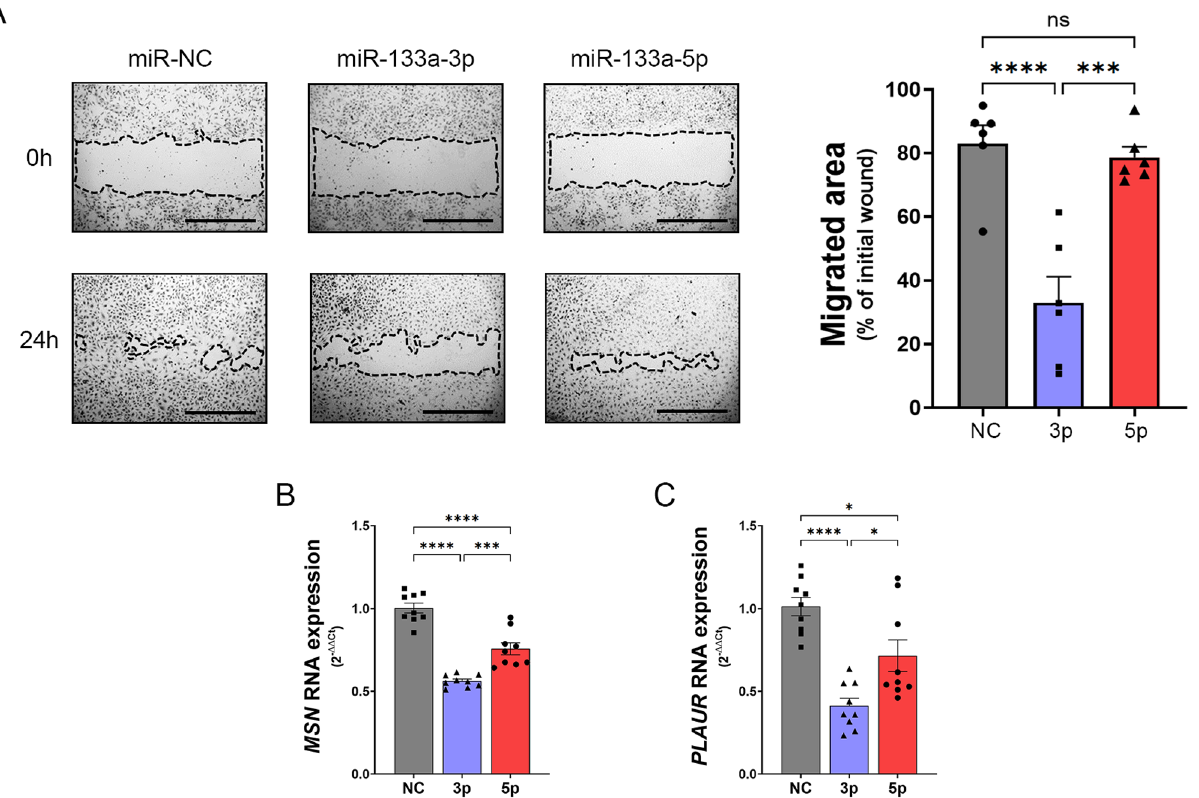
Figure 4. Aberrant expression of miR-133a-3p strongly inhibits endothelial cell migration. ( A ) Representative images of wound-healing migration assays performed with HUVEC transfected with microRNA mimics for miR-133a-3p, miR-133a-5p or a negative control (miR-NC). Images were taken at time zero (0 h) and after incubation for 24 h (24 h). The migrated area was calculated using ImageJ software (https:// imagej. nih. gov/ ij/) by subtracting the value of the non-migrated area from the wound area at time zero and expressing this as a percentage of the total area at time zero. Scale bars, 1000 μm. Data are shown as mean ± SE, n = 6. Data were analysed for statistical differences by one-way ANOVA with post hoc Tukey’s comparison test. ns = non- significant; ***, P ≤ 0.001; ****, P ≤ 0.0001. ( B , C ) TaqMan gene expression assay analysis of RNA levels for MSN and PLAUR in HUVEC transfected with microRNA mimics as above. Data are shown as mean ± SE, n = 9. *, P ≤ 0.05; ***, P ≤ 0.001; ****, P ≤ 0.0001 one-way ANOVA with post hoc Tukey’s comparison test for the indicated